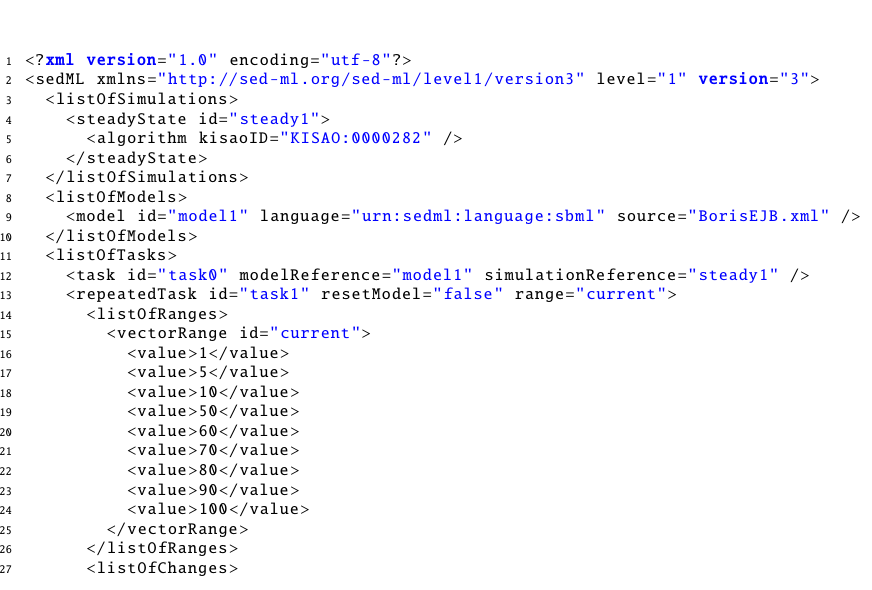
Figure A.11: The simulation result gained from the simulation description given in Listing A.7. Simulation with SED-ML web tools [2].